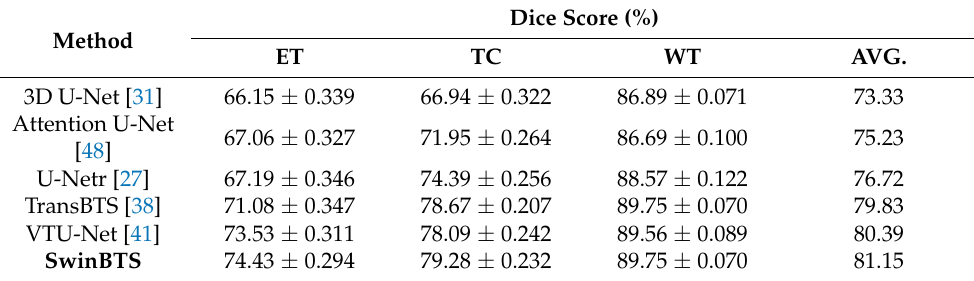
Table 1. Segmentation Dice results on BraTS 2019 test set.